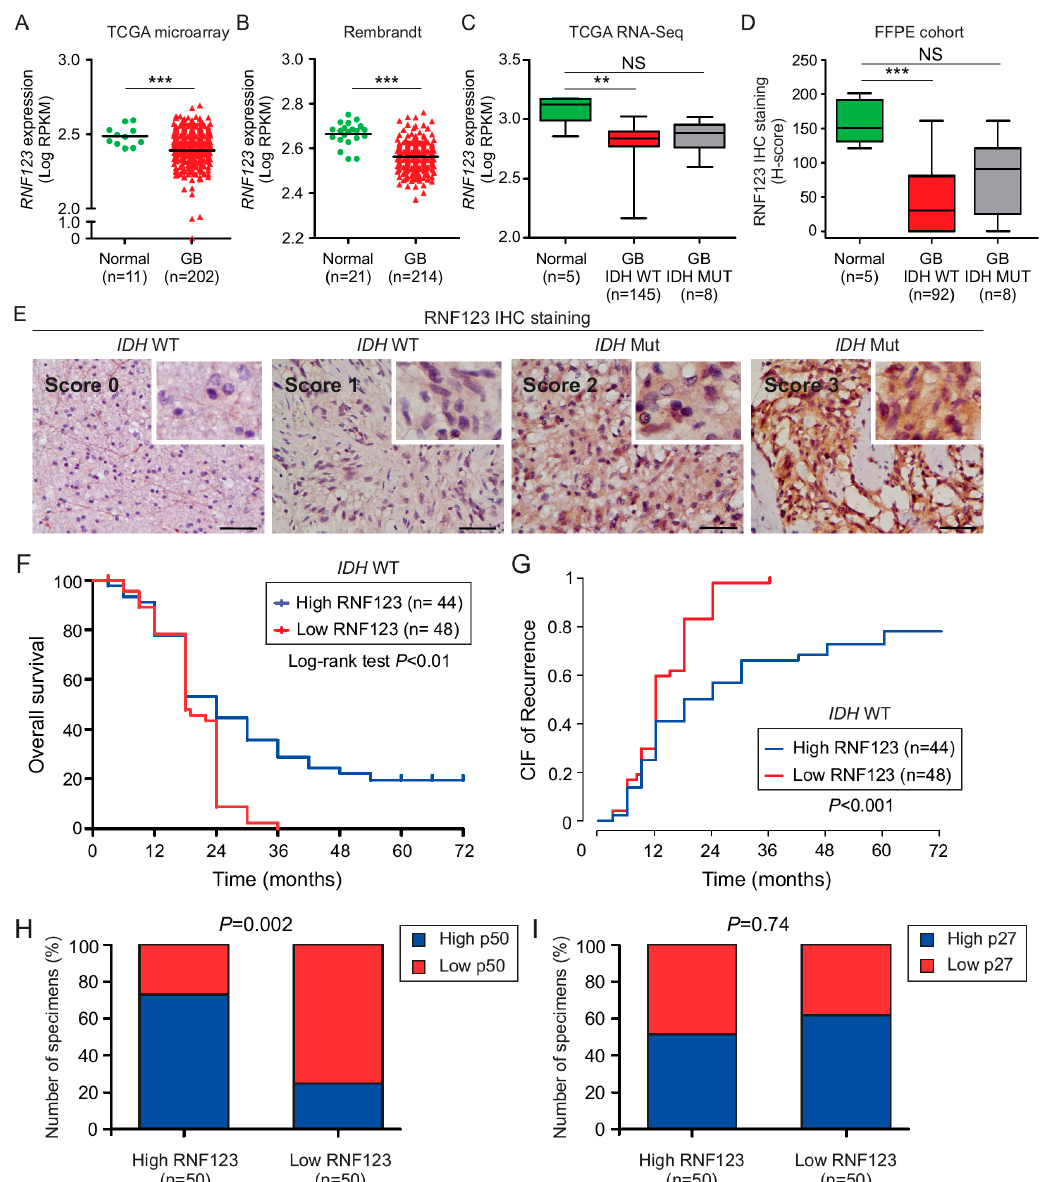
Figure 1. Analysis of RNF123 protein and mRNA expression in GB tumors. ( A , B ). Dot plot of RNF123 mRNA expression in GB ( n = 202; n = 214) tumors compared to normal brain tissue ( n = 11; n = 21, respectively) using the microarray GB TCGA database ( A ) or GB Rembrandt dataset ( B ) ( t -test *** p < 0.001). ( C ) Boxplot of RNF123 expression in IDH WT ( n = 145) or mutated ( n = 8) GB patients using RNA-sequencing TCGA dataset and compared to normal brain tissue ( n = 5) (Kruskal–Wallis test, Dunn’s post hoc test ** p < 0.01, NS = non-significant). ( D ) Boxplot of RNF123 expression in FFPE samples from normal brain tissue ( n = 5), and from IDH WT ( n = 92) or mutated ( n = 8) GB patients as determined by H-scores (Kruskal–Wallis test, Dunn’s post hoc test *** p < 0.001, NS = non-significant). ( E ) Representative IHC images for RNF123 staining in FFPE samples showing the scores (0, 1, 2, or 3). Scale bar = 50 µ m ( F ) Kaplan–Meier curves to compare the percentage of survival in GB patients with low ( n = 48) versus high ( n = 44) RNF123 expression (log-rank test, p < 0.01). ( G ) CIF of recurrence in GB patients with low ( n = 48) versus high ( n = 44) RNF123 expression ( p < 0.001). ( H , I ) FFPE samples derived from GB patients were classified as high or low RNF123 expression based on the median of H-scores and analyzed by IHC for p50 ( H ) or p27 ( I ). The percentages of patients with high or low expression of p50 ( H ) or p27 ( I ) are shown (Fisher’s exact test, p = 0.002 ( H ) and p = 0.74 ( I